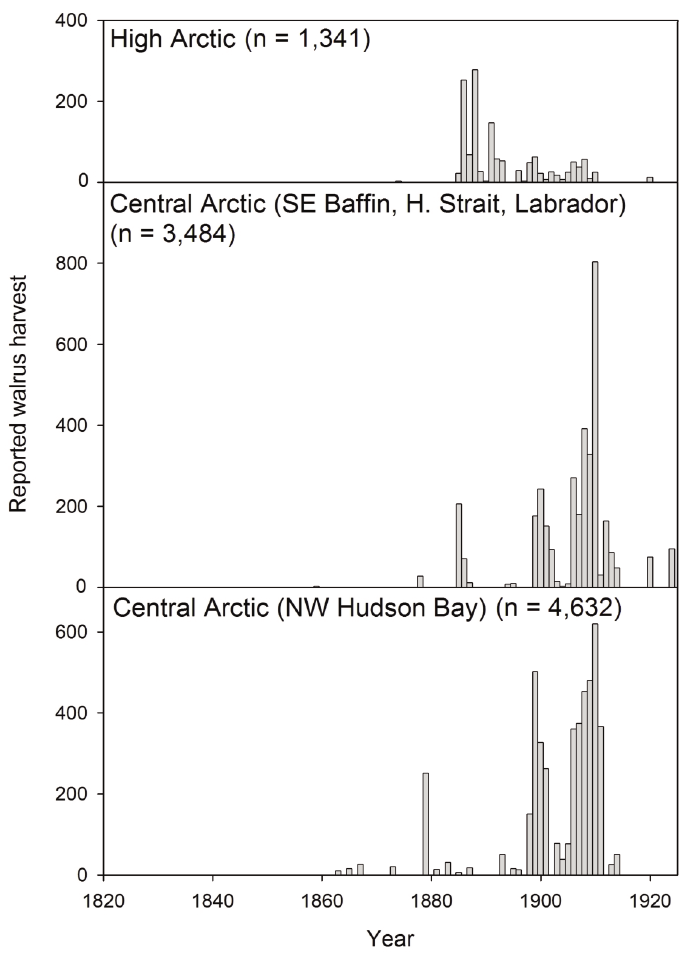
Fig. 12. Commercial